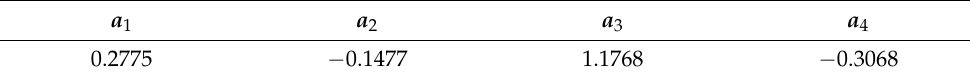
Table 4. Coefficient value.